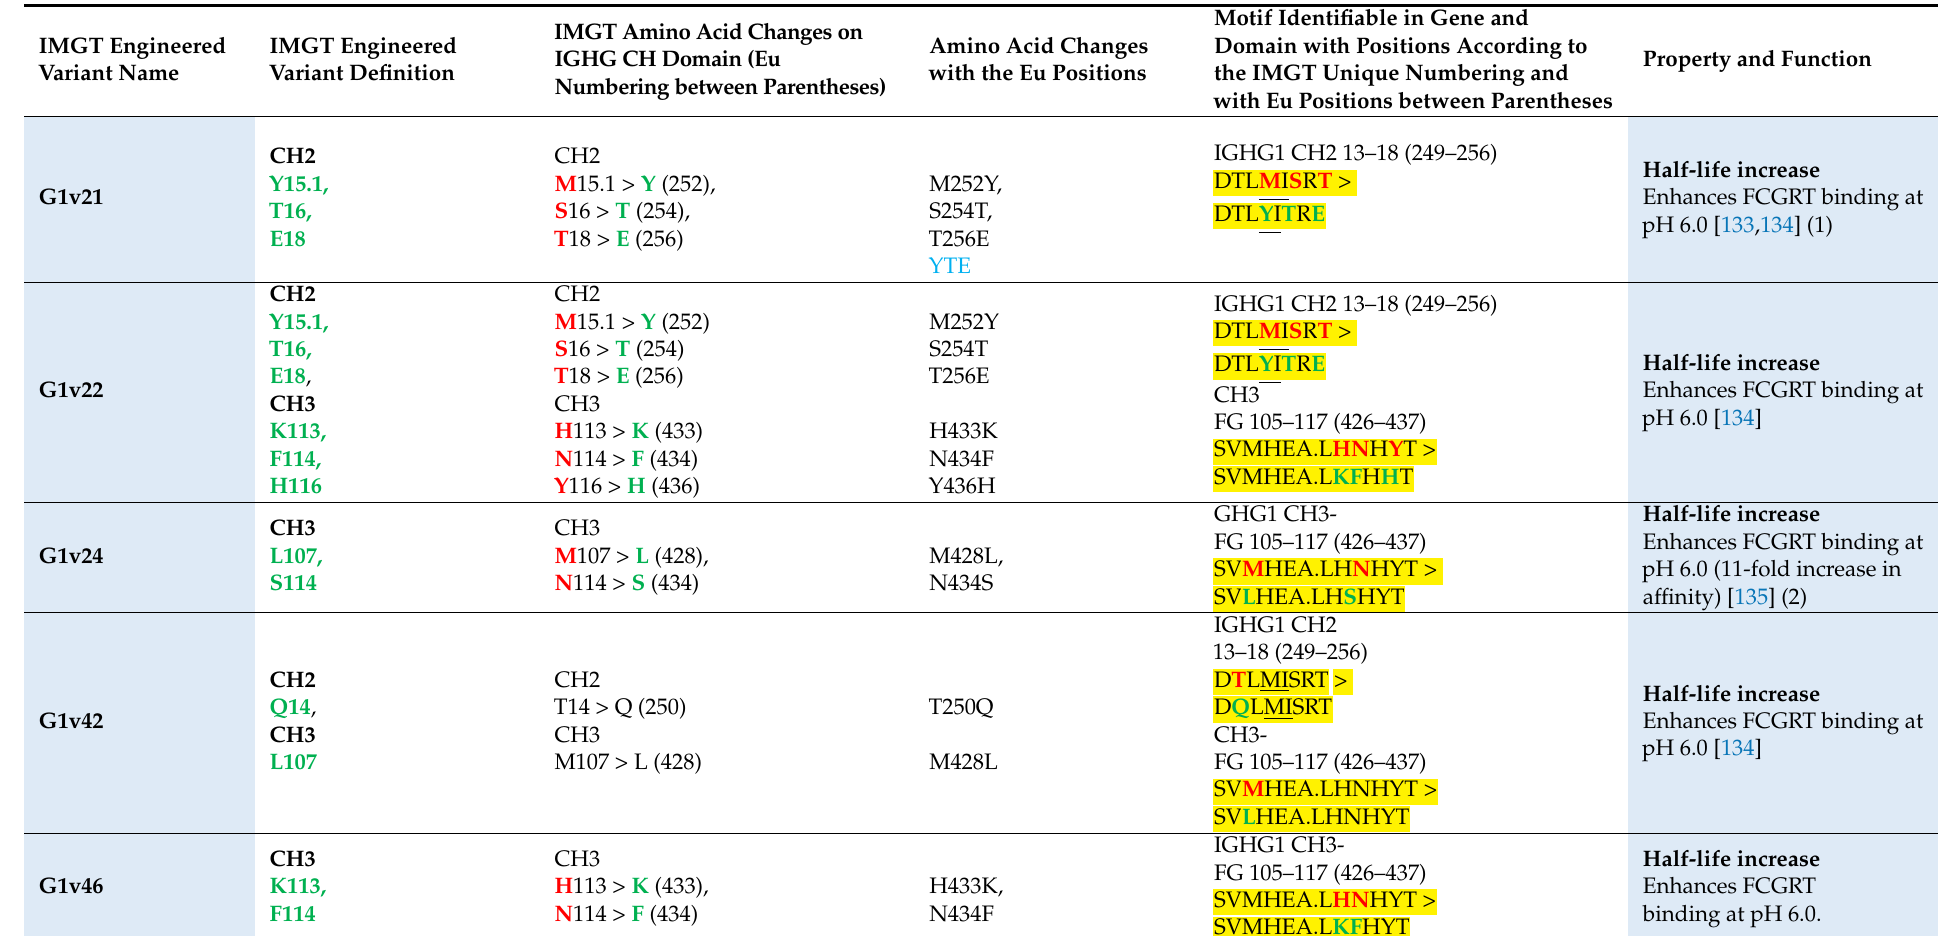
Table 13. IMGT nomenclature, Eu positions and IMGT motif of engineered Fc variants involved in half-life increase (Half-life